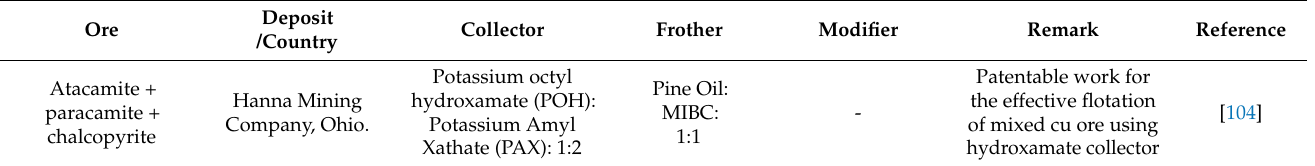
Table 9. Reagents for the mixed copper ore (sulphide and